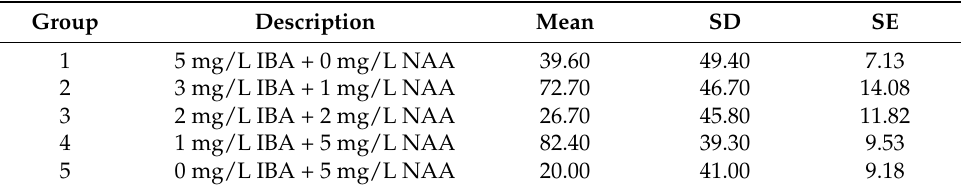
SD = standard deviation. SE = standard error of